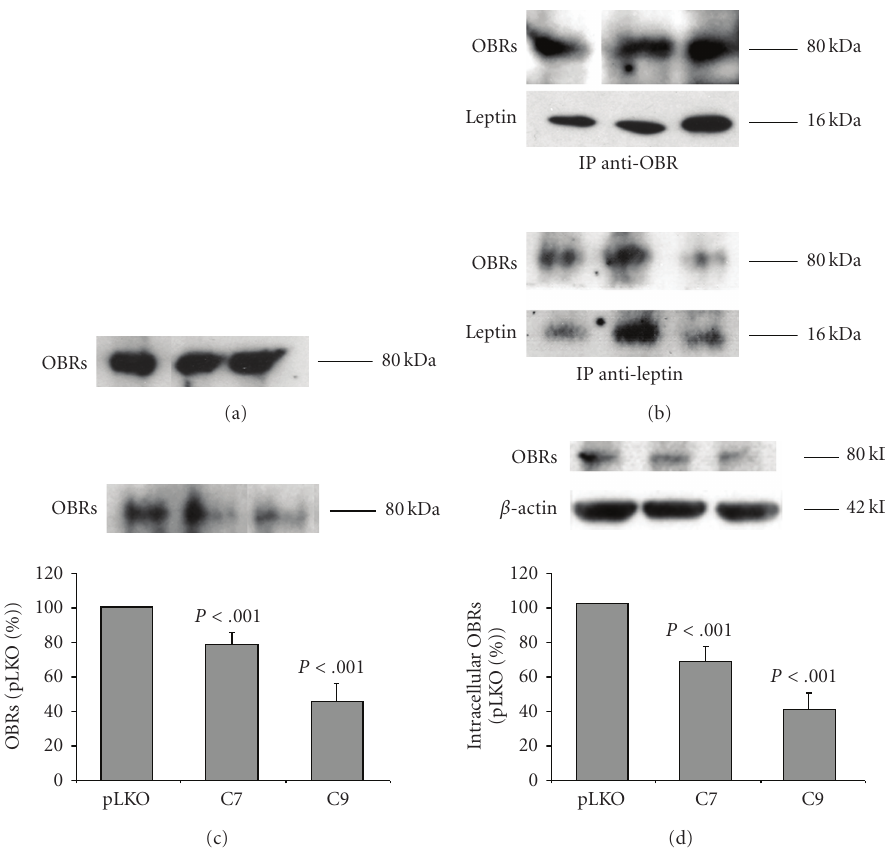
Figure 5: Presence of the soluble leptin receptor (OBRs) in the basal compartment of Caco-2/15 cell culture . (a) Detection of the soluble leptin receptor (OBRs) by immunoblot was carried out on the basal medium of 3 di ff erent experiments. (b) Immunoprecipitation of the media using the antibody against leptin receptor reveals the presence of the soluble receptor (80 kDa) associated to leptin (16kDa); inversely, immunoprecipitation with the leptin antibody led to the same bands. Levels of soluble leptin receptor were measured in supranatant culture media (c) and in homogenates (d) from cells infected with pLKO.1, C7 or C9 virus. OBRs levels in basal media and cell homogenates were significantly decreased by C7 or C9. Bars represent the mean values ± s.e.m ( n =